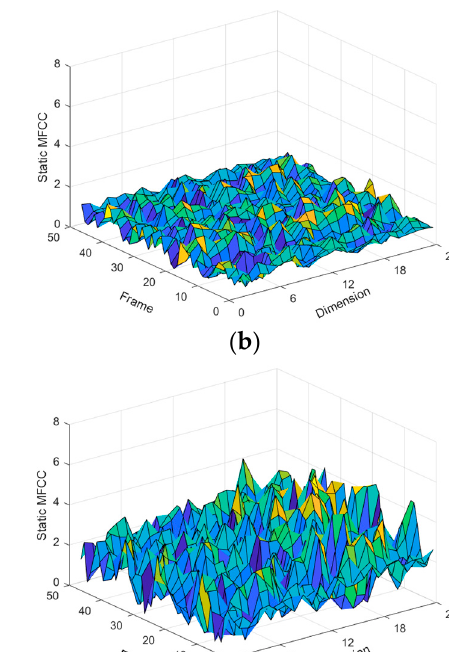
( c ) Creeping discharge; ( d ) Metal protrusions.